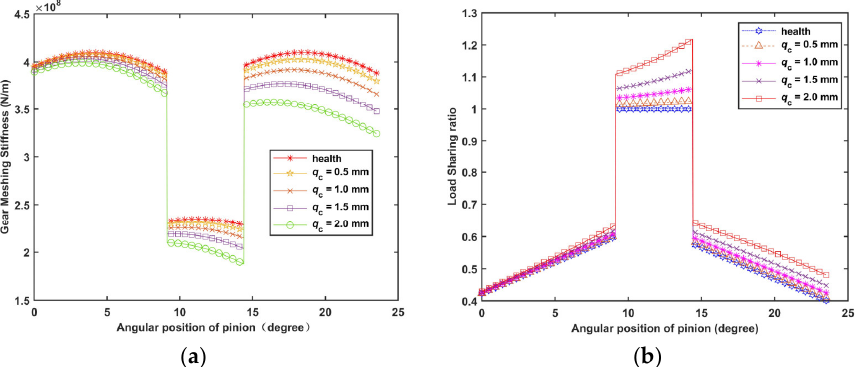
Figure 7. TVMS and LSR with different crack depths: ( a ) TVMS; ( b ) LSR.